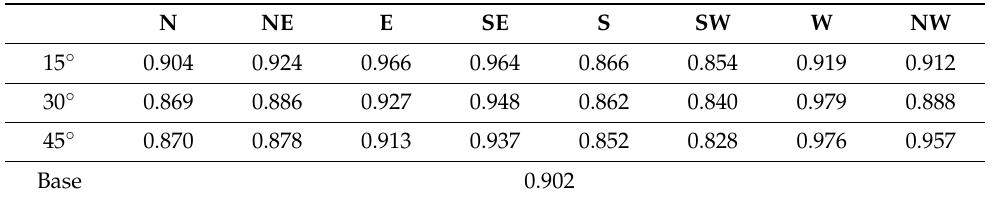
Table 3. Ammonia uniformity index (UI) data according to the various injection angle and direction candidates at the 400 mm distance from the urea injection